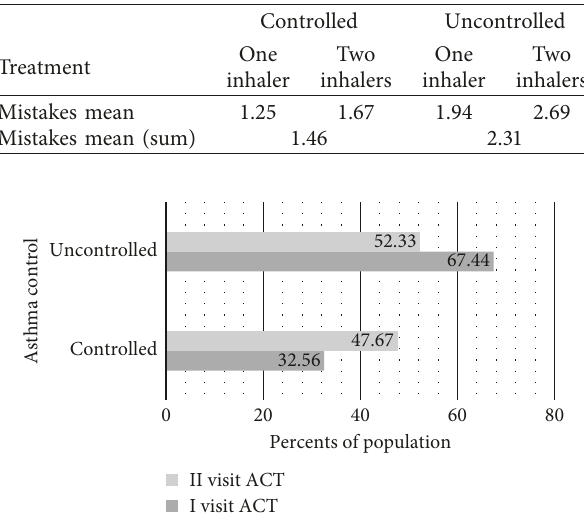
Figure 3: Comparison of asthma control in serial visits.